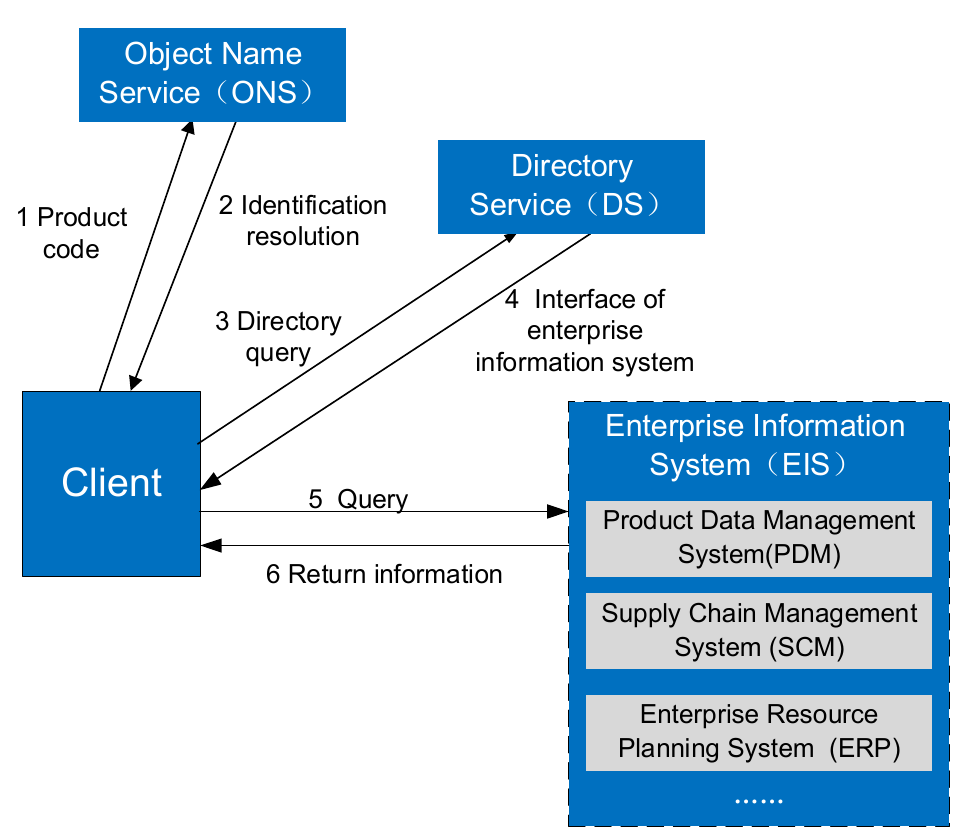
Figure 4. Integration solution with enterprise information systems (EIS).